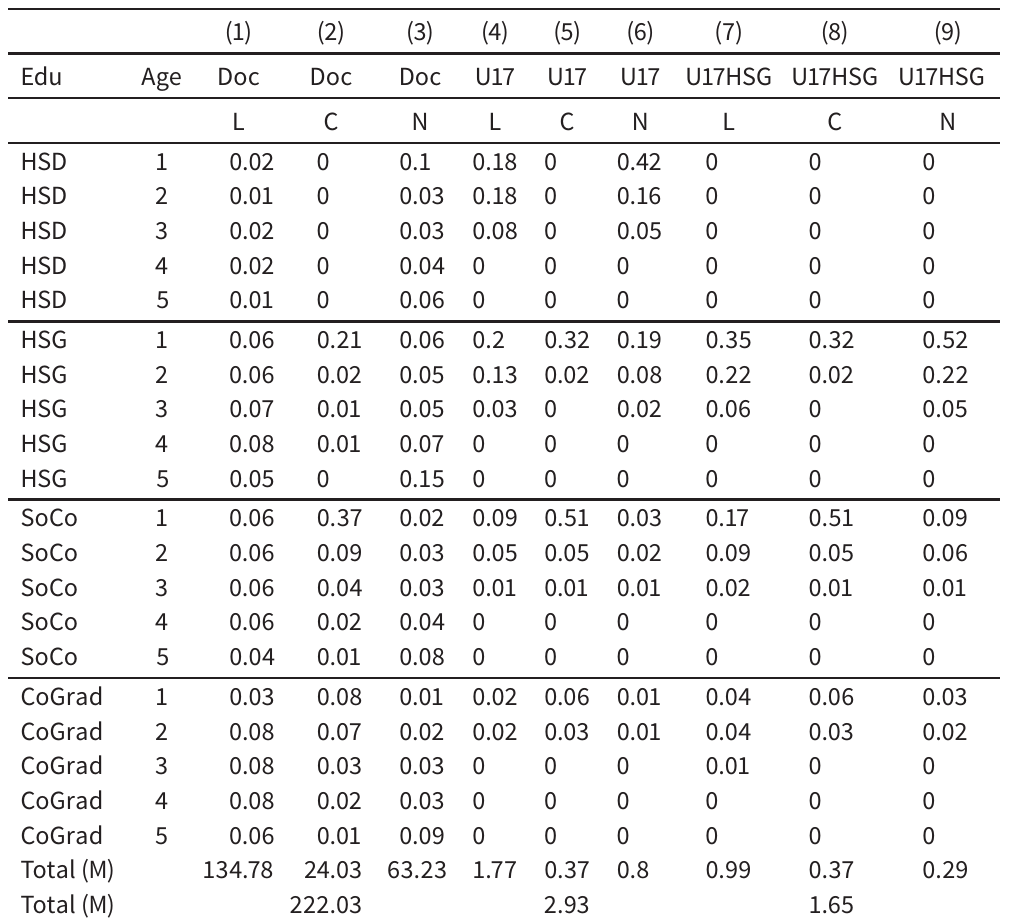
Baseline Data (2012 ACS) on Documented Population and DREAMers. Shares of Column